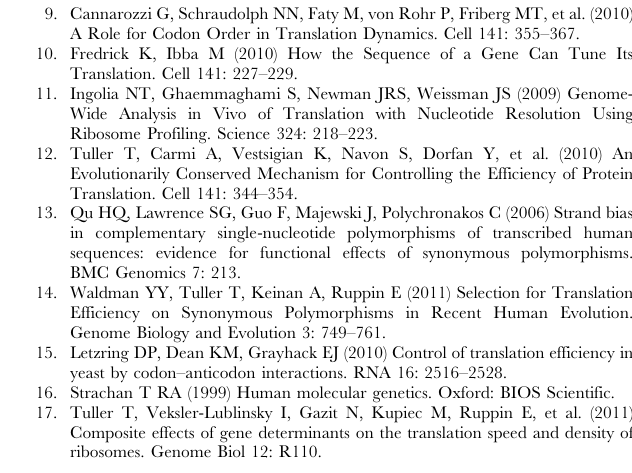
Table S1 Human codon usage calculated by the EMBL human coding sequences (CDS) data release 115.